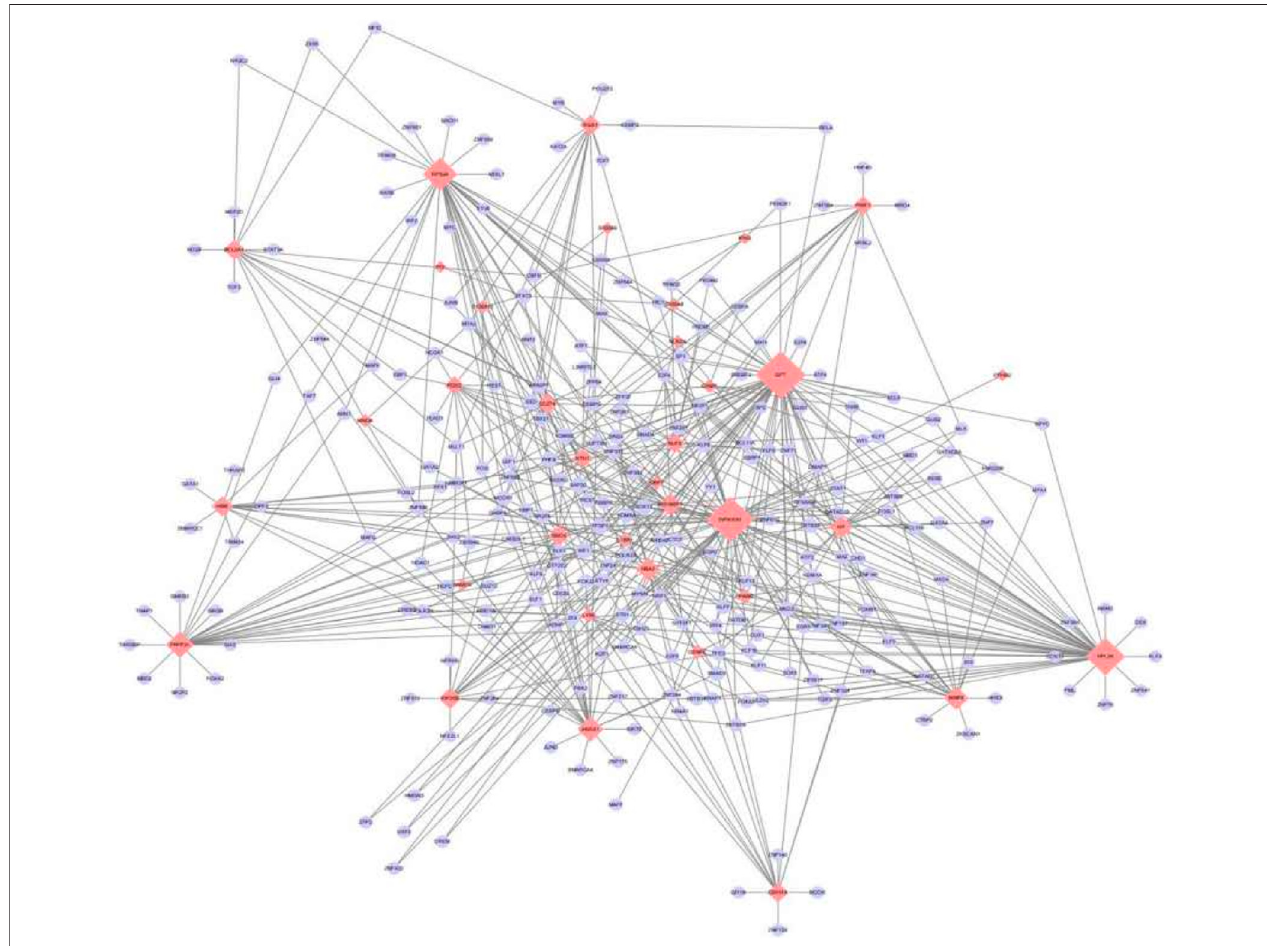
FIGURE 6 | TF-mRNA Regulatory network. The blue oval represents the transcription factor, and the red diamond represents the gene. The greater the degree of connection, the larger the node, the more important it is in the network.